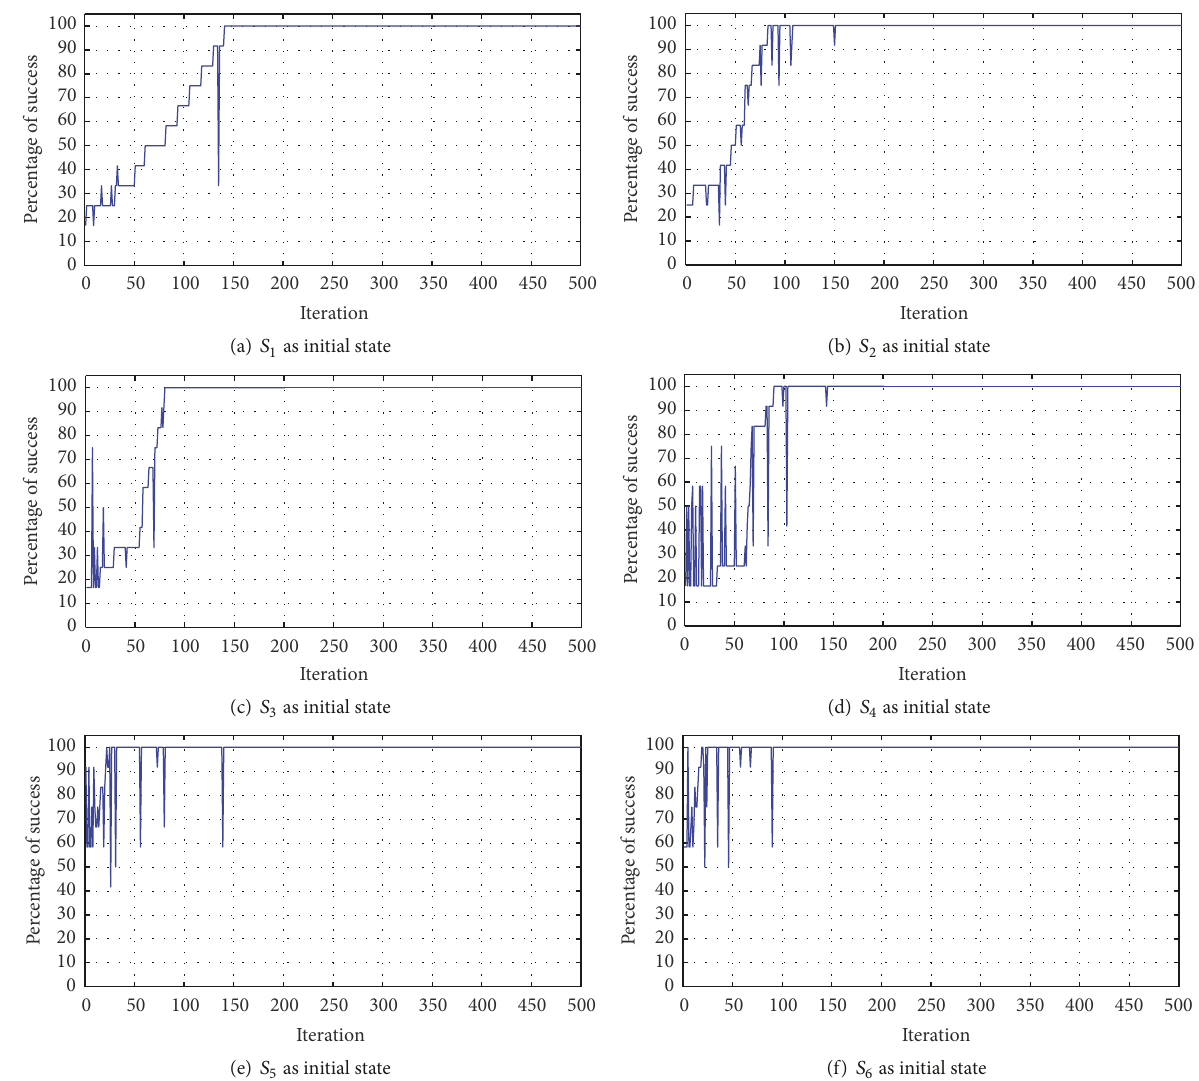
Figure 6: Simulation results for different initial states.